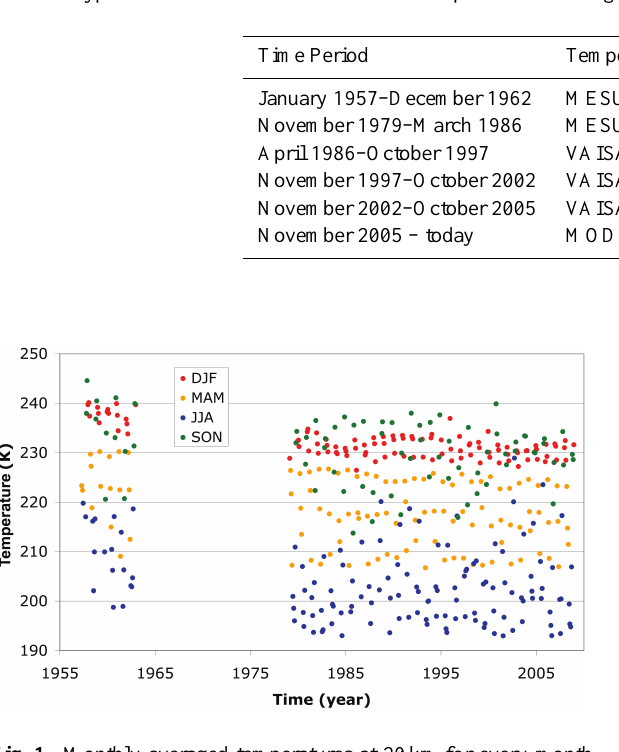
Fig. 2. Mean seasonal temperature profiles differences between the 1979–2008 and the 1957–1962 periods over Dumont d’Urville, for (a) summer, (b) autumn, (c) winter and (d) spring. One-sigma stan- dard deviations are